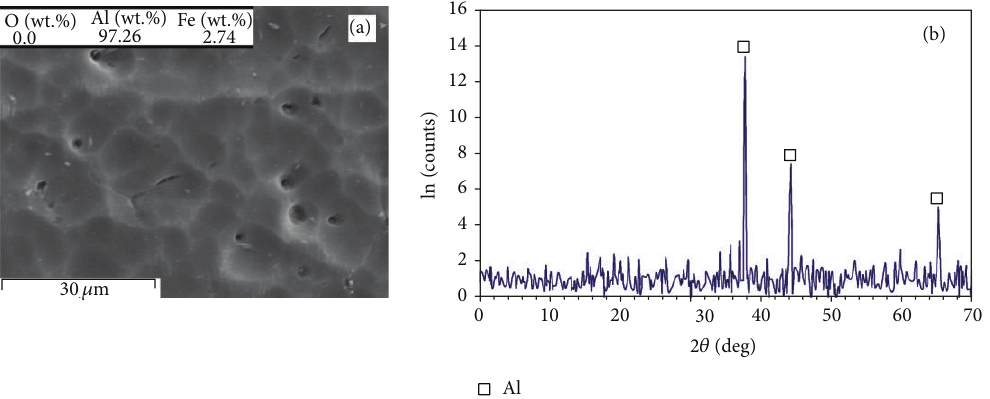
Figure 3: (a) Typical SEM microstructural view showing a granular structure (overall chemical composition was acquired by EDS) and (b) XRD pattern of the part fabricated on a thick powder bed using 𝑃 = 51 W and V = 0.14 m/s.